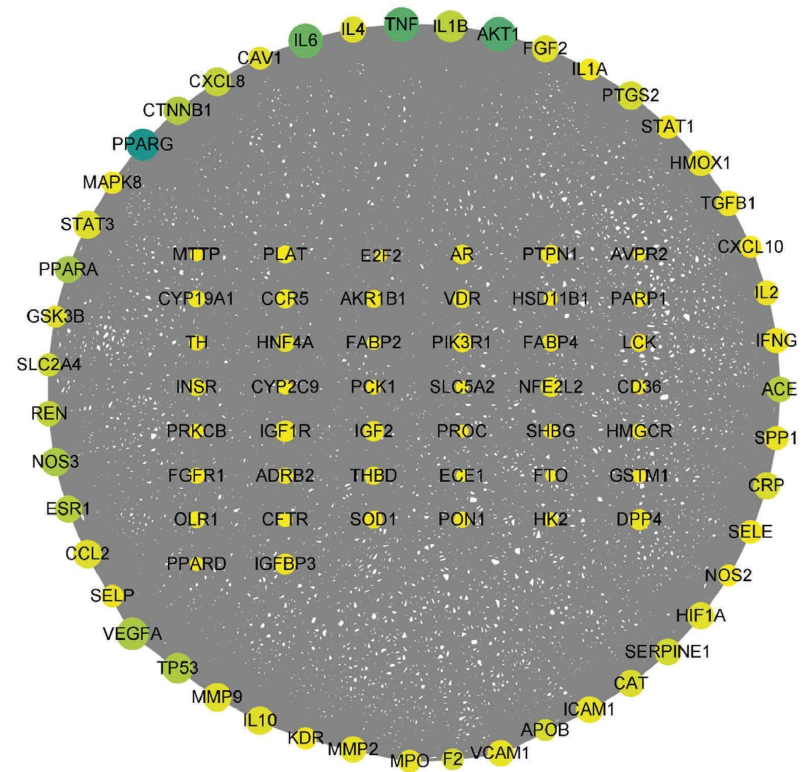
Figure 3: PPI network